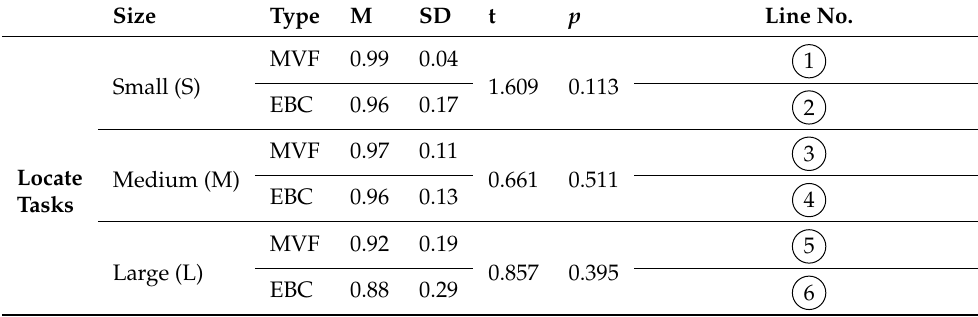
Table 3. Means of accuracy, with the standard deviation of the measured mean in